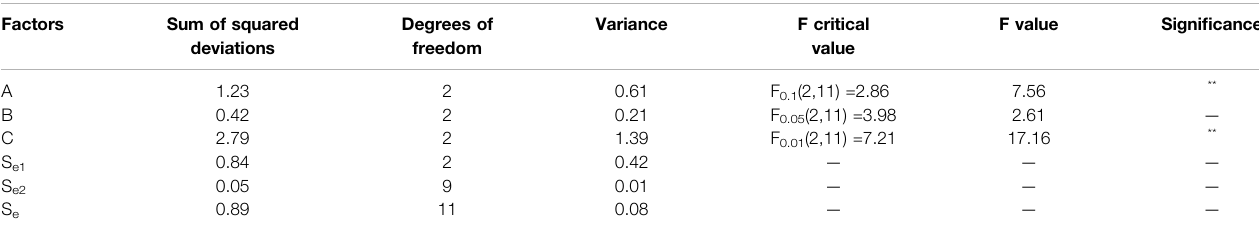
TABLE 9 | Analysis of variance for the ultimate tensile strain